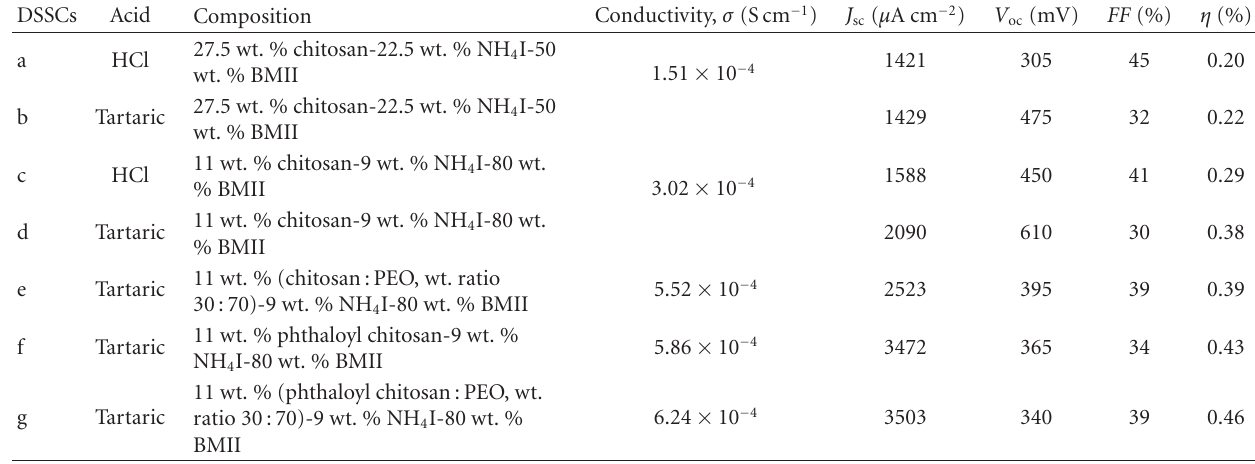
Table 4: V oc , J sc , FF , and η of DSSC employing red cabbage anthocyanin and di ff erent electrolytes in gel form.